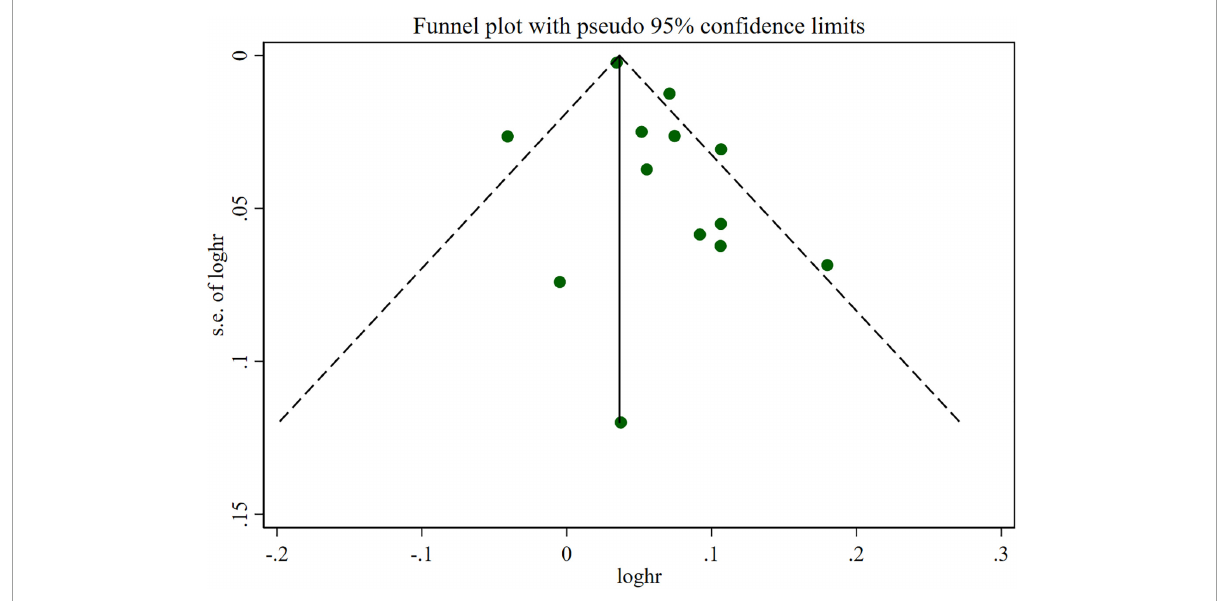
FIGURE4 Funnel plots of relative risks of atrial fibrillation per 1 drink/day increment in alcohol